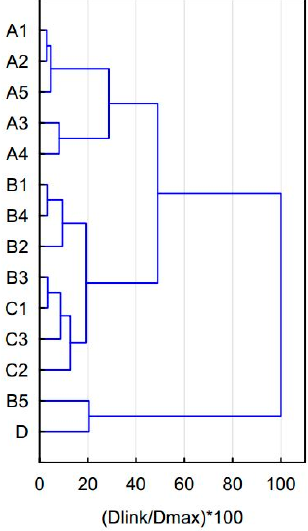
Figure 4. Dendrogram (Ward’s method) obtained from the standardized estimations from portable gamma spectrometry of K, eU, and eTh. Dlink/Dmax corresponds to the multivariate distance between measurements that is normalized by the maximum distance between measurements in order to present dissimilarity measures in percentage of the maximum difference.